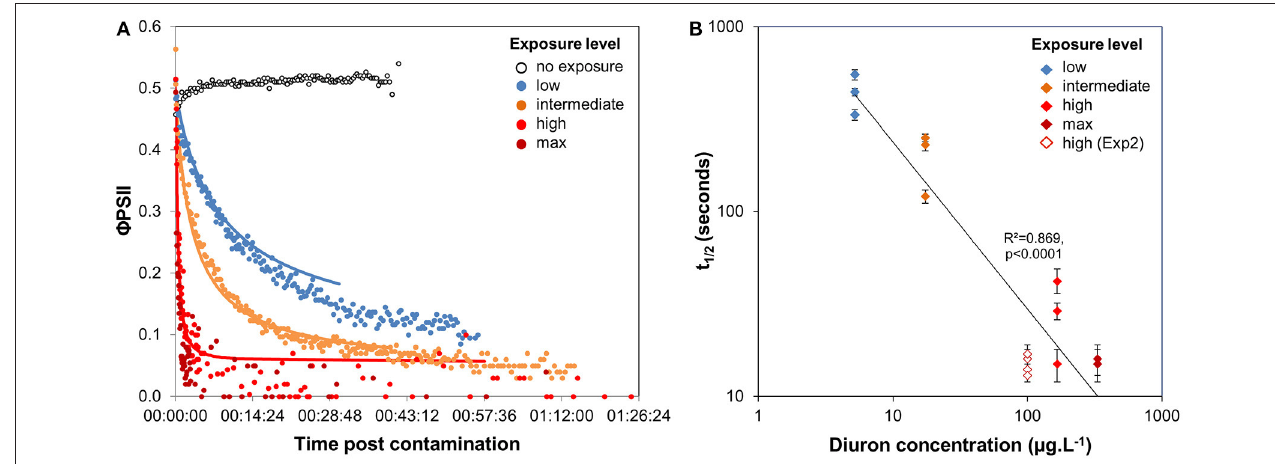
FIGURE 2 | (A) Time-response curves based on ϕ PSII decrease post diuron addition (Experiment 1); values are average of 3 replicates, except for the highest concentration (2 replicates available). A summary of the ecotoxicity parameters extracted from the curves are provided in Table 1 . (B) Variation of t 1 / 2 with diuron exposure concentration. Error bars indicate t 1 / 2 confidence intervals (95%) for the individual time-response